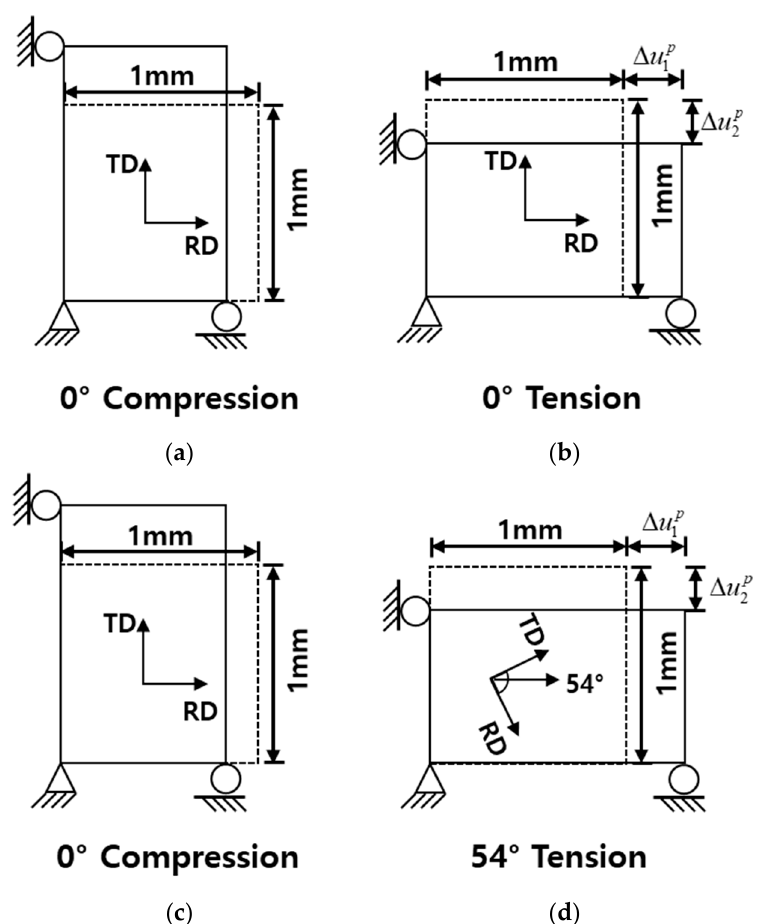
Figure 3. Boundary conditions for the one element compression–tension analysis: ( a ) 5% compression along RD followed by ( b ) 10% tension along RD, ( c ) 5% compression along RD followed by ( d ) 10% tension along 54° to RD. Dashed line and the solid line represent before deformation and after deformation, respectively.